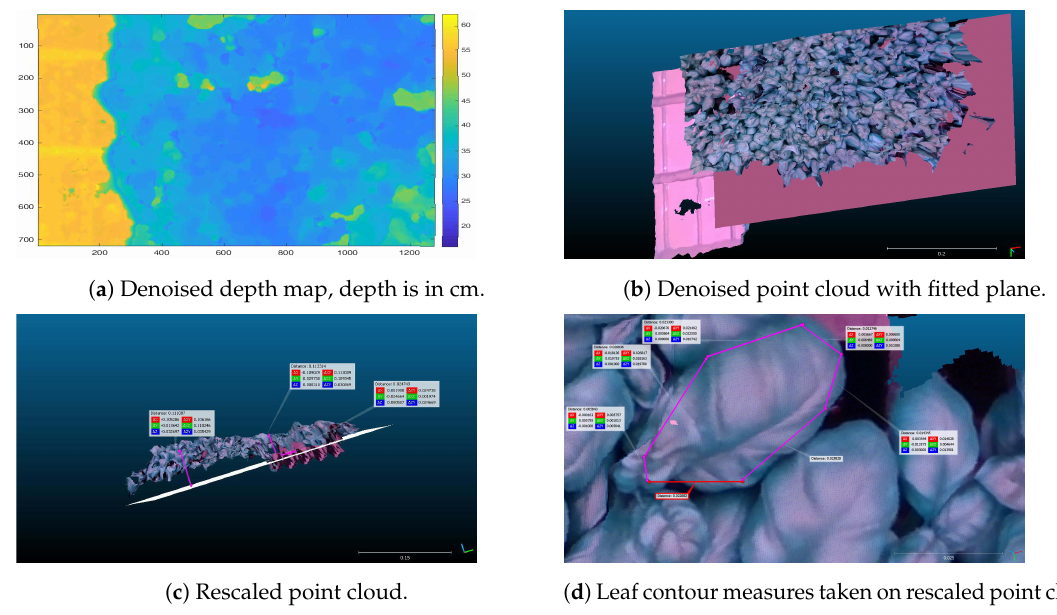
Figure 4. The figure shows relevant preprocessing steps for both depth map and point